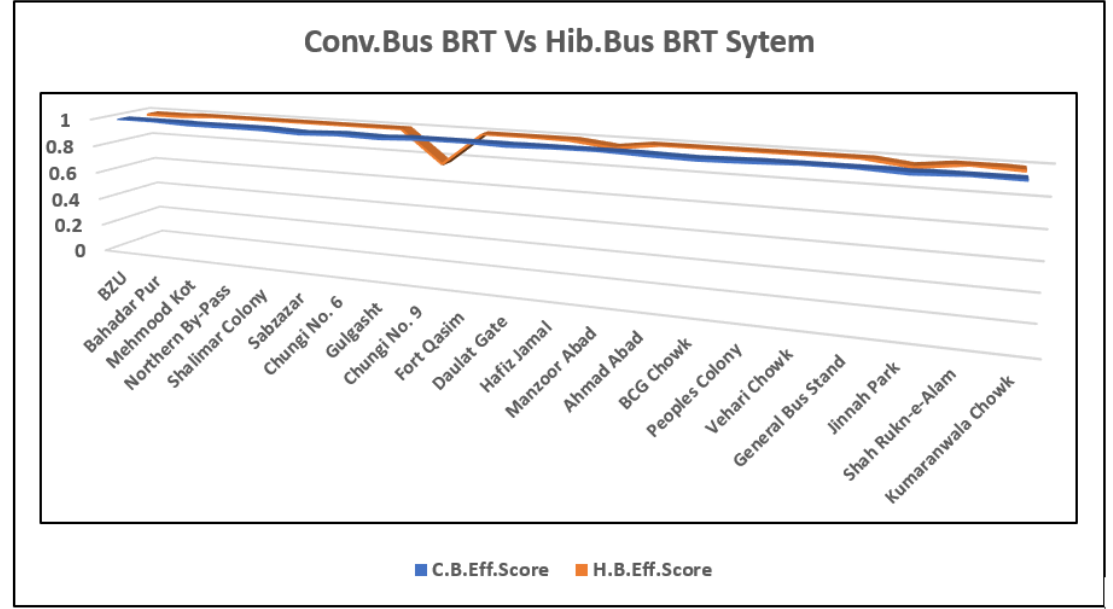
Figure 8. Comparative Performance Analysis of Conventional Fuel Bus vs. Hybrid Fuel Bus System Analysis.